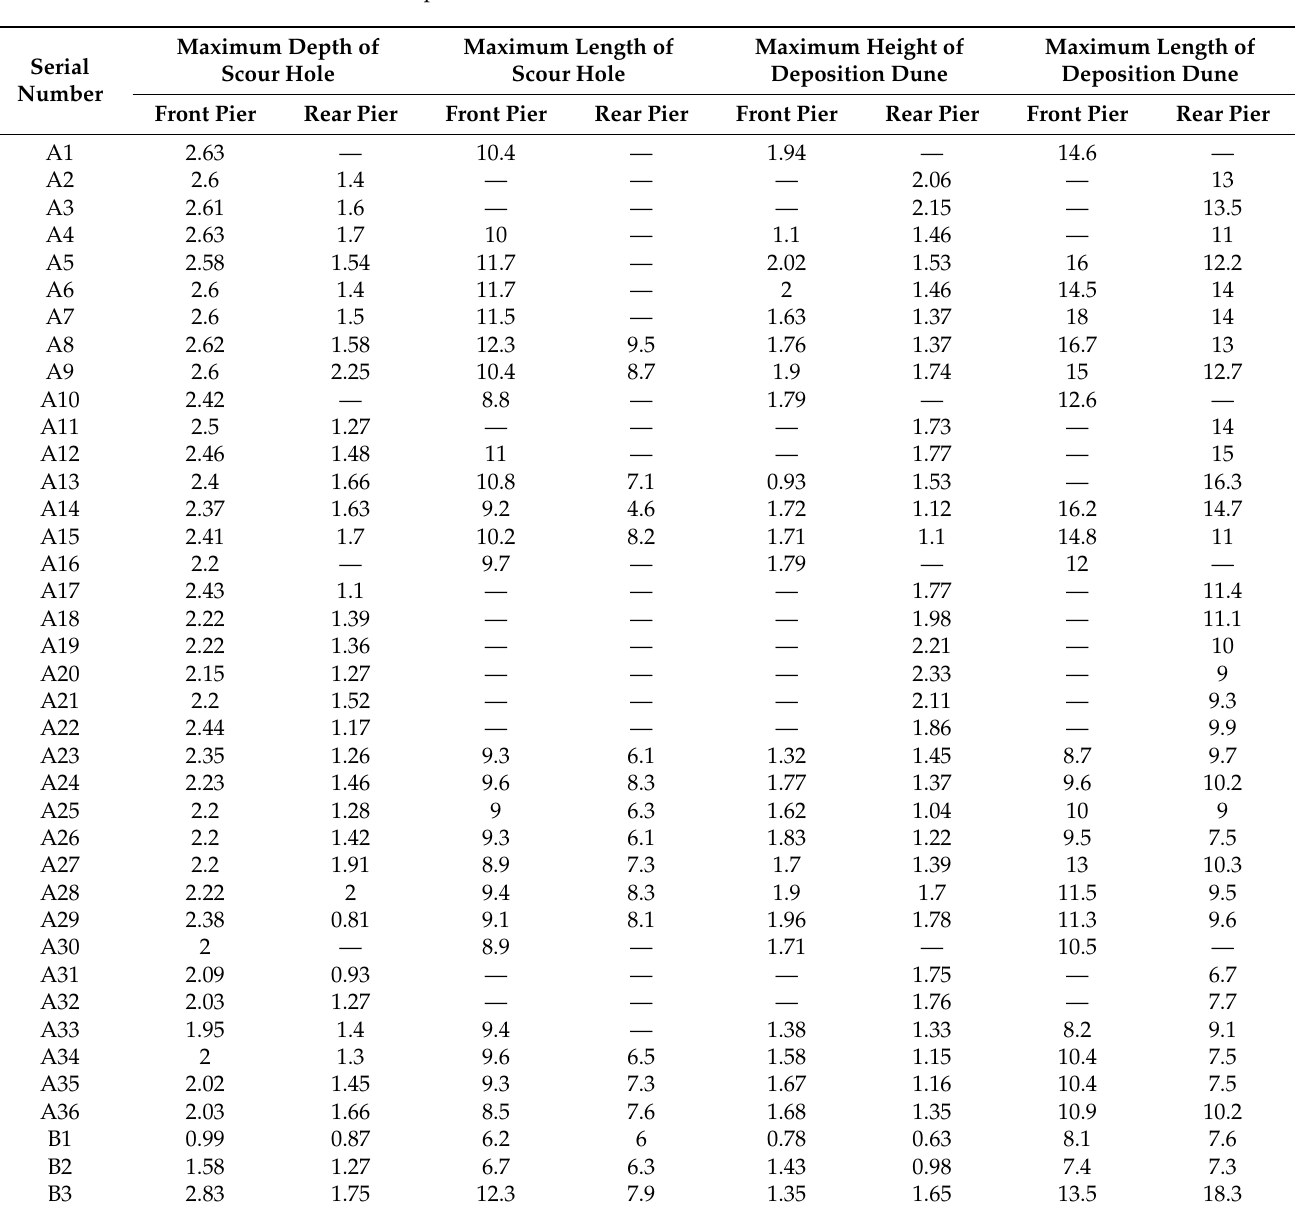
Table 2. Experiment